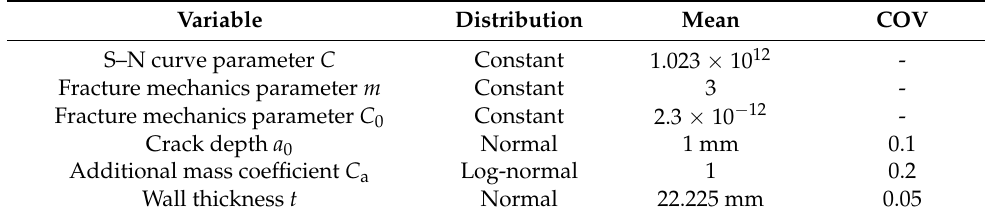
Table 6. Basic parameters for fatigue reliability